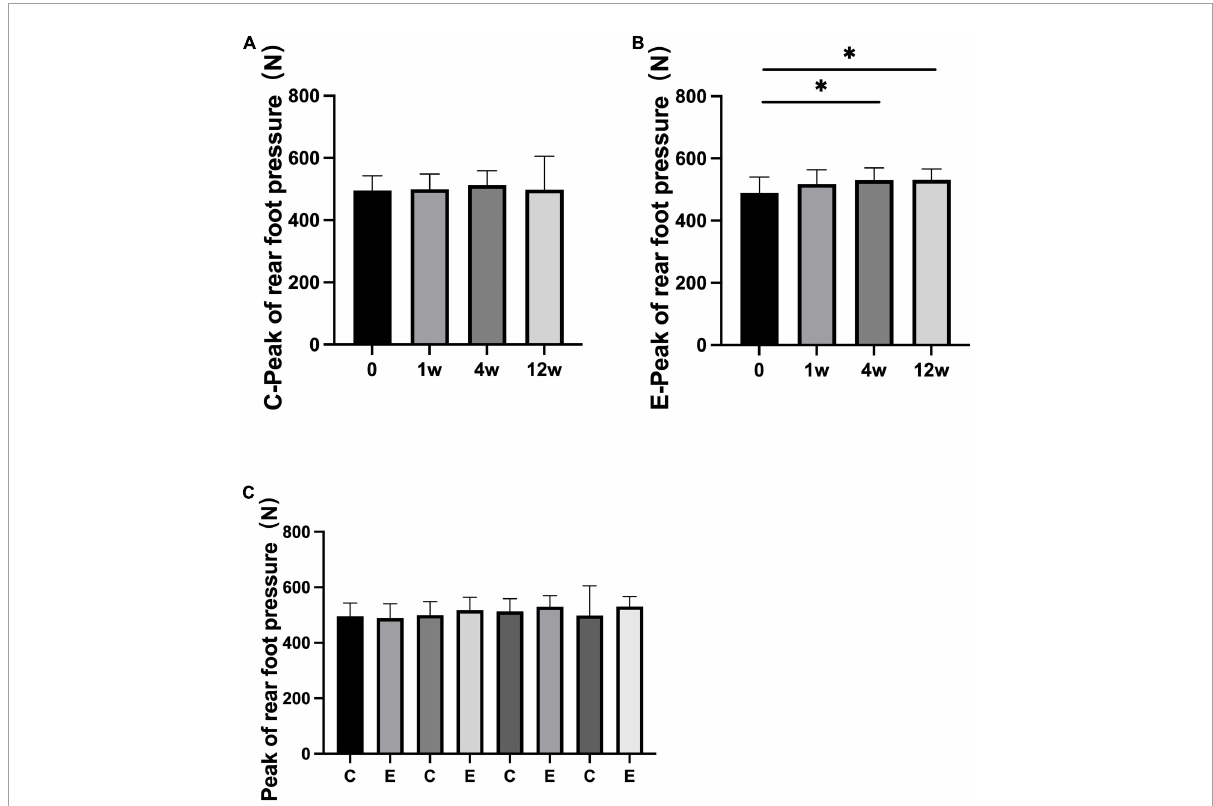
FIGURE8 Changes in peak of rear foot pressure ( N ). (A) Rear foot pressure in control group at 1, 4, and 12 weeks compared with that at 0 week; (B) rear foot pressure at 1, 4, and 12 weeks compared with that at 0 week in experimental group; (C) rear foot pressure at 0, 1, 4, and 12 weeks in experimental group compared with control group; ∗ p <